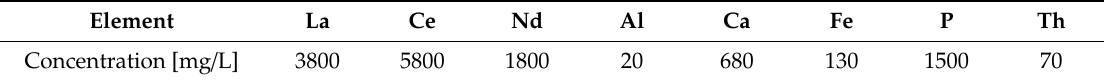
Table 6. Metal ion concentration of a typical leach solution with high impurity content.